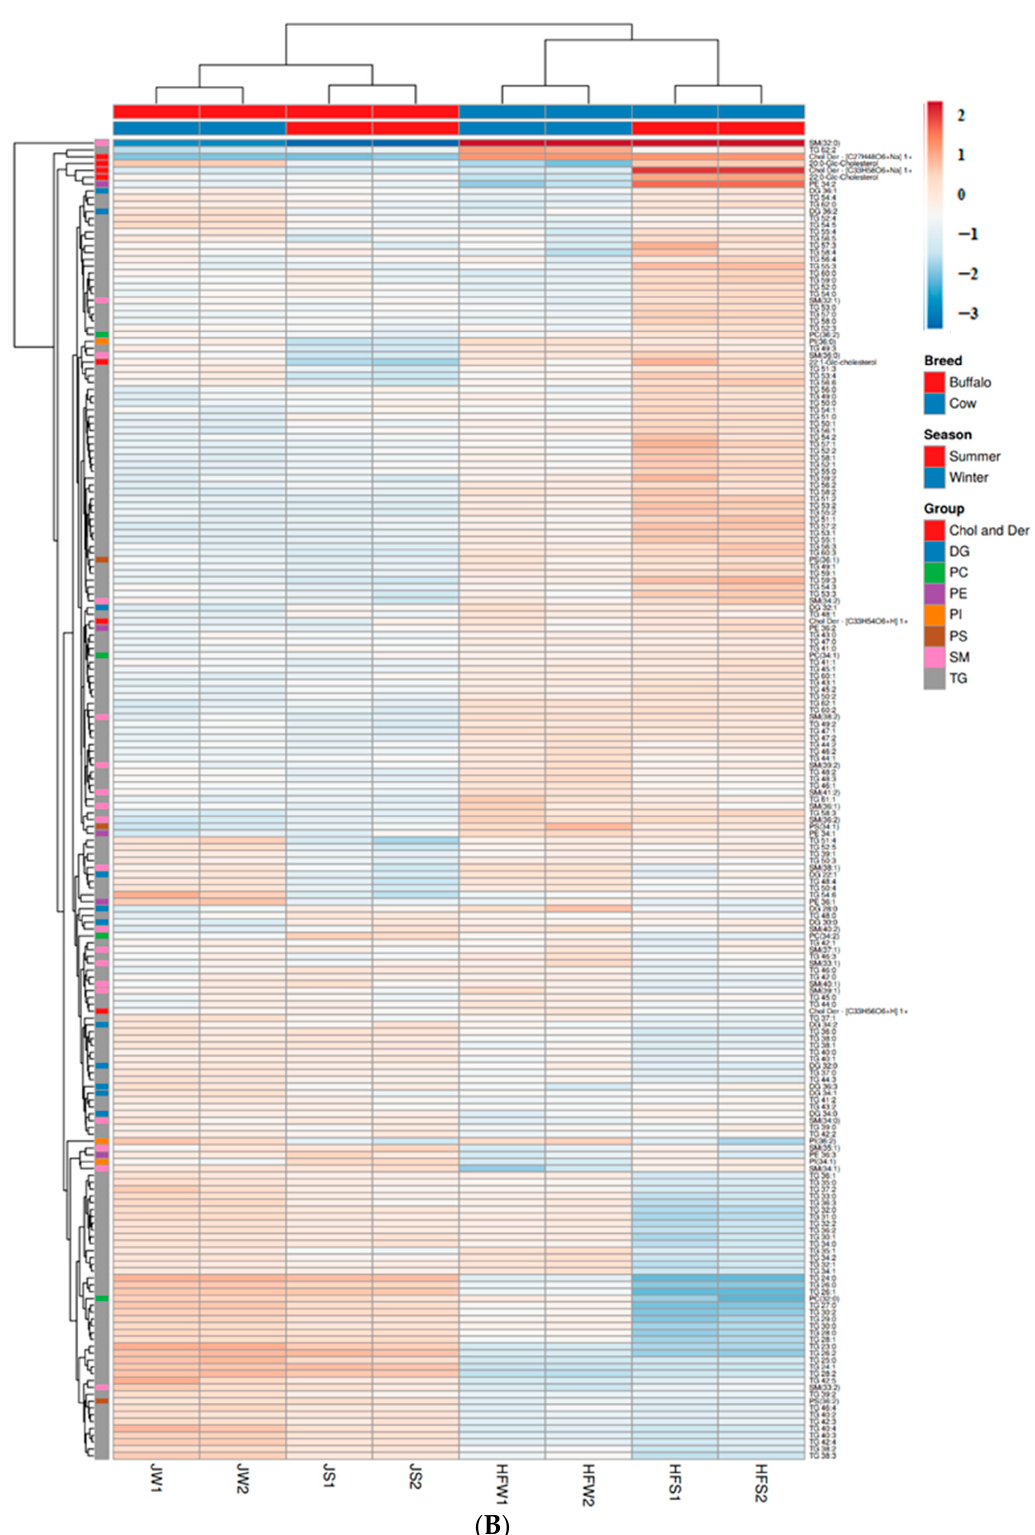
Figure 6. Clustering of samples. Dendrograms (columns) showing the similarity between the HF and J samples based on the ( A ) 141 TG species and ( B ) 193 lipid species. The row dendrograms on the Y-Axis show the clusters based on the lipid species. Corresponding heat maps showing the variation of molecular species between the samples are also displayed.